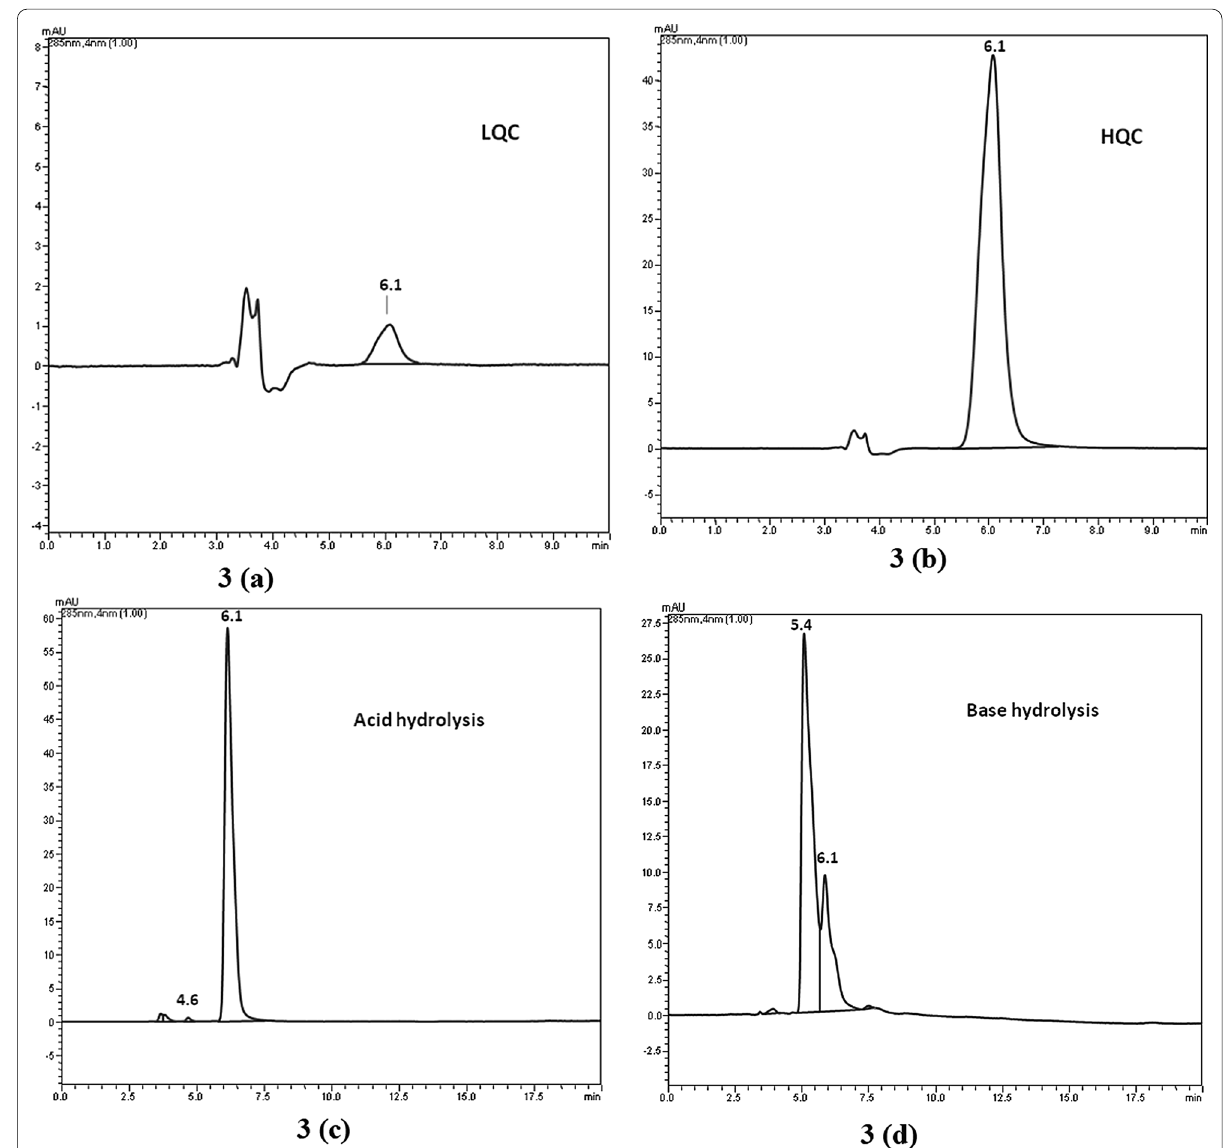
Fig. 3 Representative HPLC chromatograms for a lowest quality control (LQC ~ 250 ng/mL), b highest quality control (HQC ~ 12,000 ng/mL, c acid hydrolysis, d base hydrolysis, e oxidation, f thermal